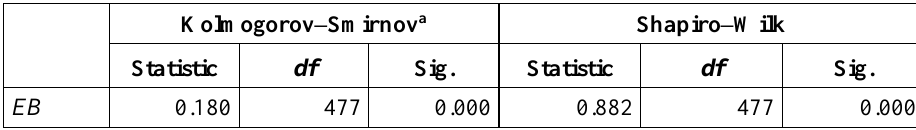
Table 1. EB normality